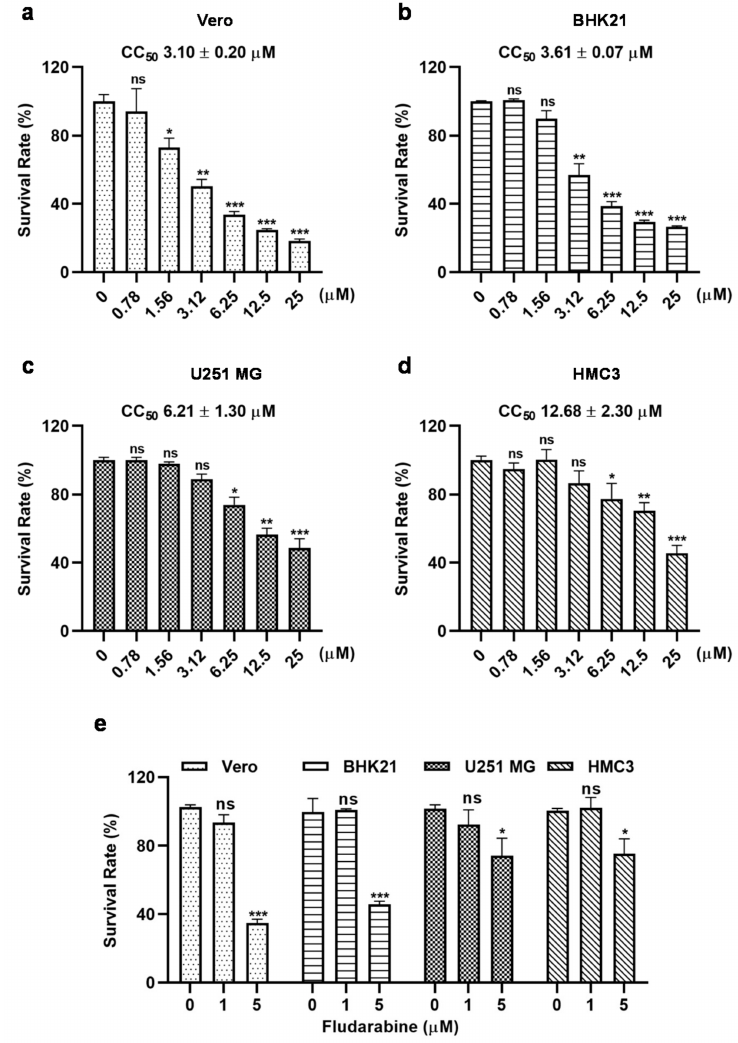
Figure 6. Cytotoxicity of fludarabine. ( a – e ) Cytotoxicity of fludarabine in Vero, BHK21, U251 MG, and HMC3 cells. Cells were incubated with the indicated concentrations of fludarabine for 48 h, followed by measuring cell viability using CCK8 assay. The differences between groups without and with fludarabine at different concentrations were evaluated by two-tailed Student’s t test. Data are presented as mean ± SD; *, p < 0.05; **, p < 0.01; ***, p < 0.001; ns, no